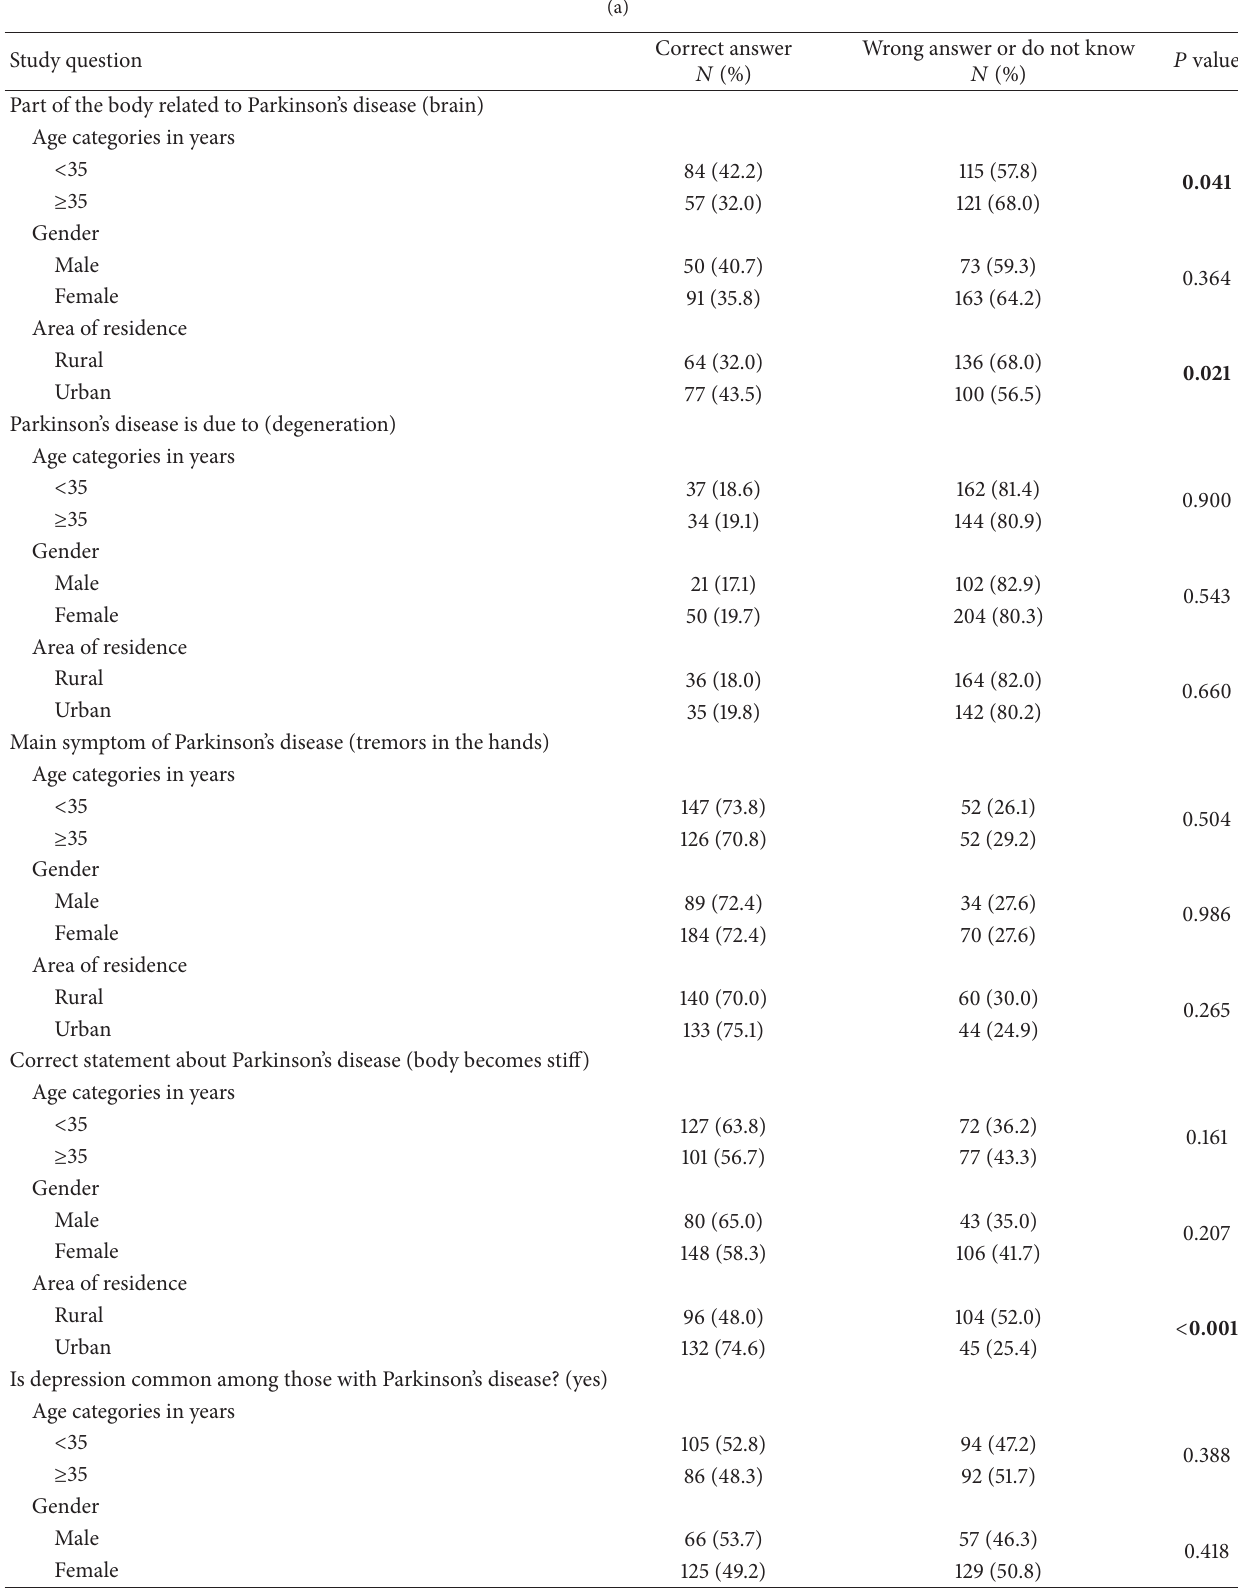
Table 3: (a) Participants’ knowledge of Parkinson’s disease cause and symptoms by their demographic characteristics. (b) Participants’ knowledge of Parkinson’s disease by their demographic